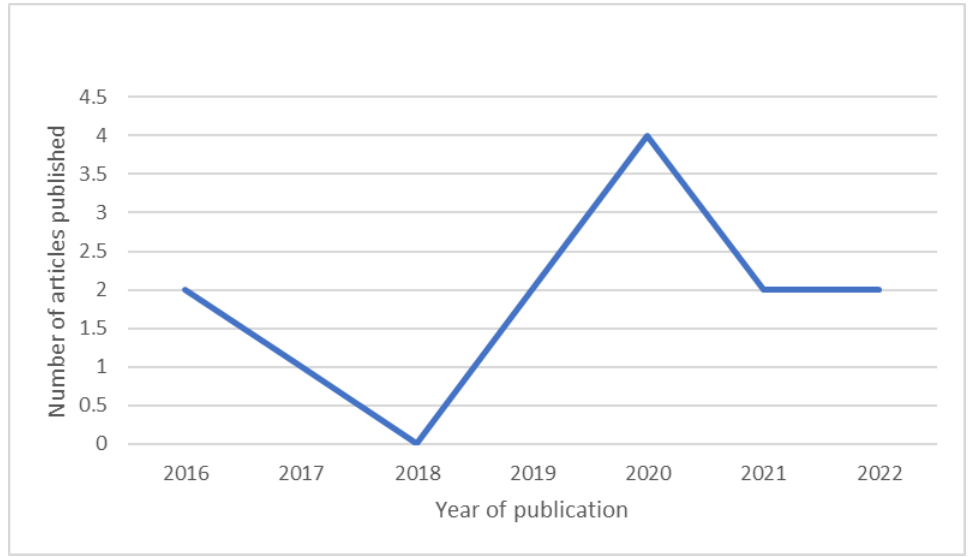
Figure 3. Number of selected articles published between 2016 and 2022.